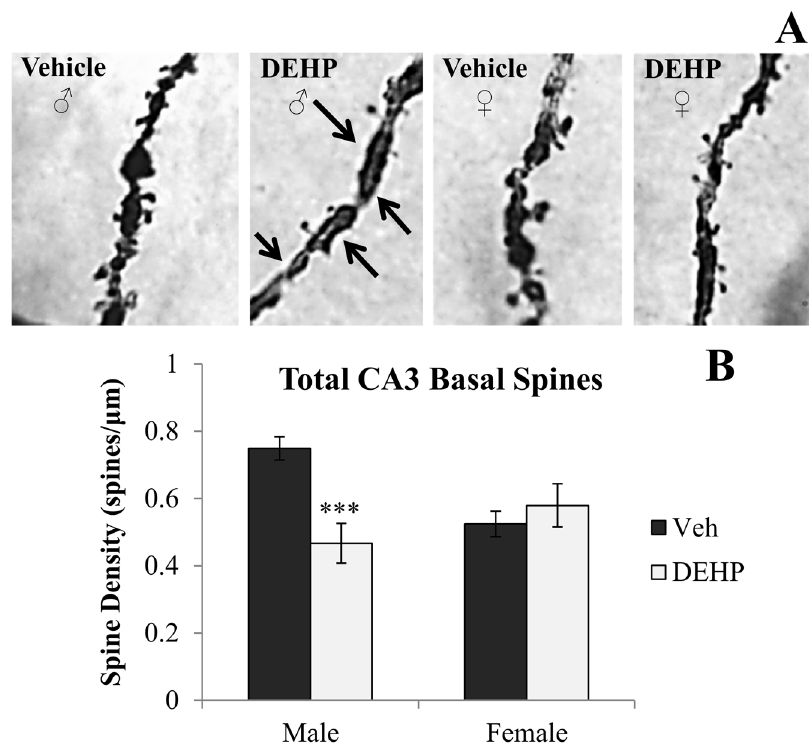
Figure 2. Spine density on basal dendrites of dorsal CA3 hippocampal neurons. (A) Representative photomicrographs of spine density on fourth order basal dendritic branches of CA3 neurons (100x). Quantification of the total number of basal dendritic spines per m m (B) in male and female rats exposed to di(2-ethylhexyl) phthalate (DEHP) compared to controls (Veh). Male rats exposed to DEHP showed a significant reduction in spine density on CA3 basal dendrites compared to controls. Arrows in the DEHP-male image show regions of reduced dendritic spine density. There was no significant effect of DEHP treatment on CA3 basal spine density in female rats compared to controls. Error bars represent standard error of the mean. ***= p ,